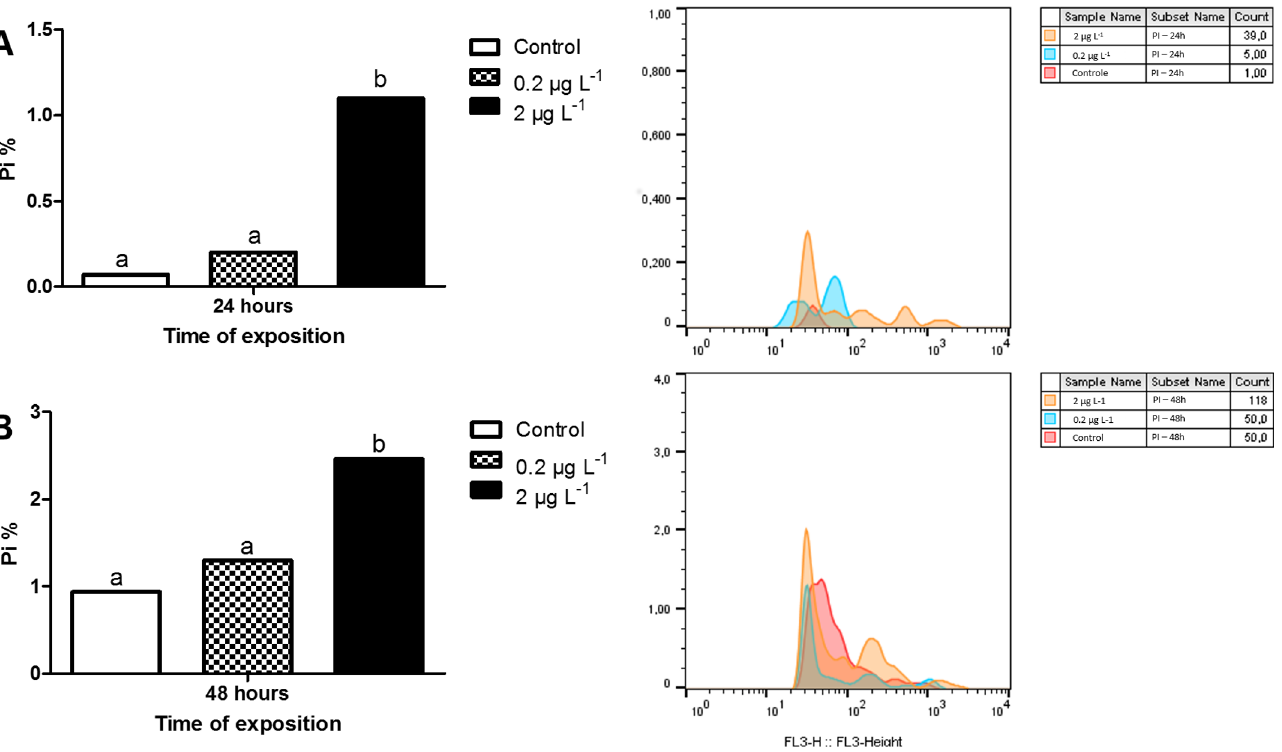
Fig 3. Percentages of erythrocytes labeled by PI in ex vivo assay. (A) Exposure to 2 μ g L -1 and 0.2 μ g L -1 in 24 and (B) 48 hours. On the right, PI fluorescence histograms 24 and 48 hours respectively. Values followed by different letters differ by Fisher test (p < 0.05).